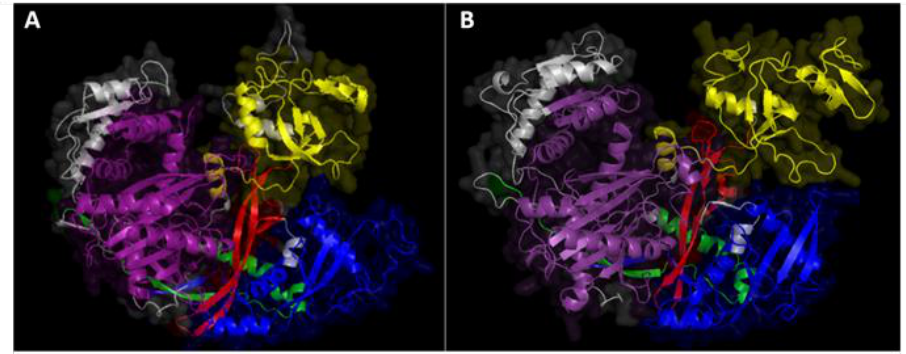
Figure 1. Predicted 3D structures of ( A ) M. oryzae MoAGO1 and ( B ) MoAGO3. Structures were modeled with SWISS-MODEL and domains were highlighted with PyMOL: blue = N-domain, red = DUF1785, yellow = PAZ (Piwi Argonaut and Zwille), green = L2, purple = PIWI (P-element Induced WImpy testis), the rest of the sequence with no domain predicted is colored in grey.